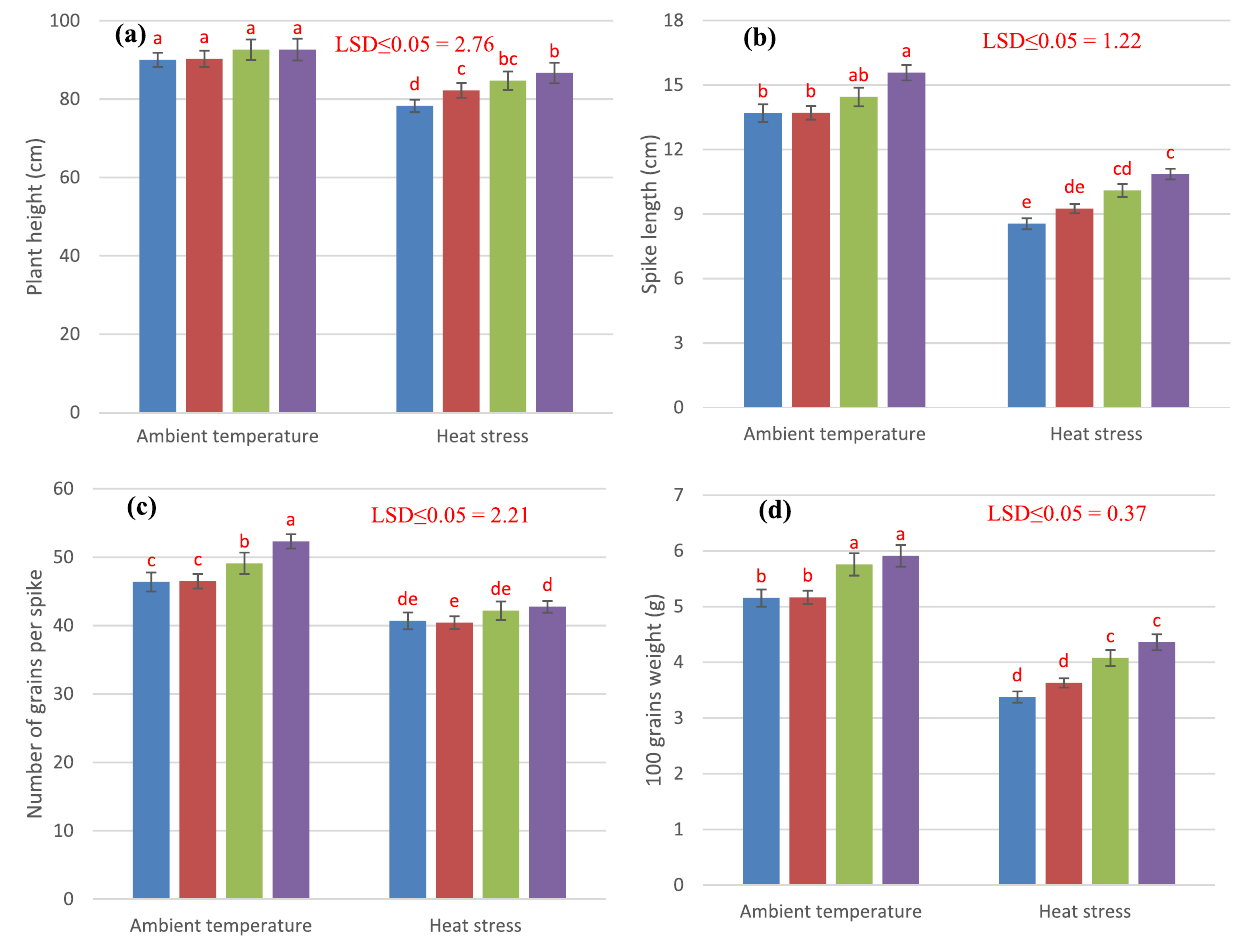
Figure 6. Influence of exogenously applied Si on plant height ( a ), spike length ( b ), number of grains per spike ( c ) and 100 grains weight ( d ) of wheat under ambient temperature and heat stress. Values are the mean SE of four